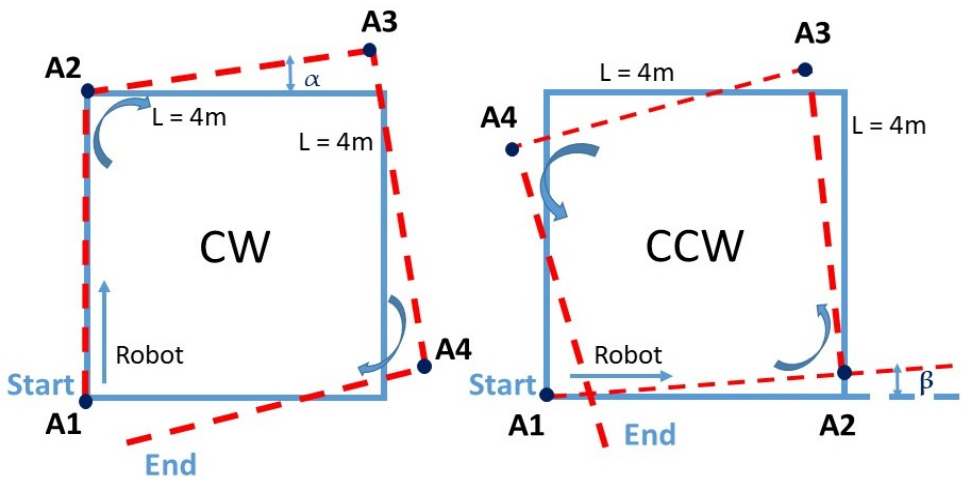
Figure 4. The diagram of a square path clockwise and counterclockwise.